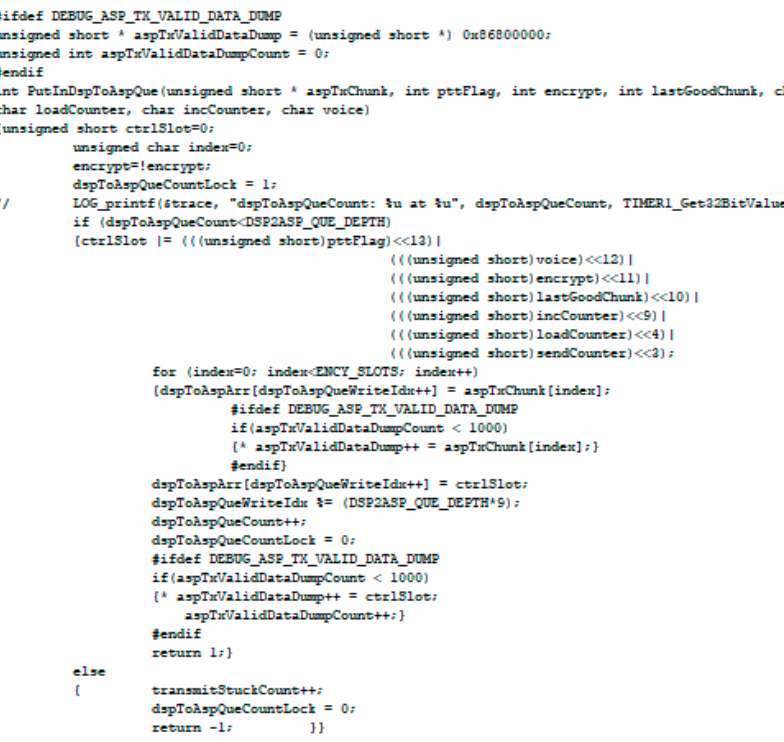
Figure 19. Code used whenever data are transmitted through serial port.